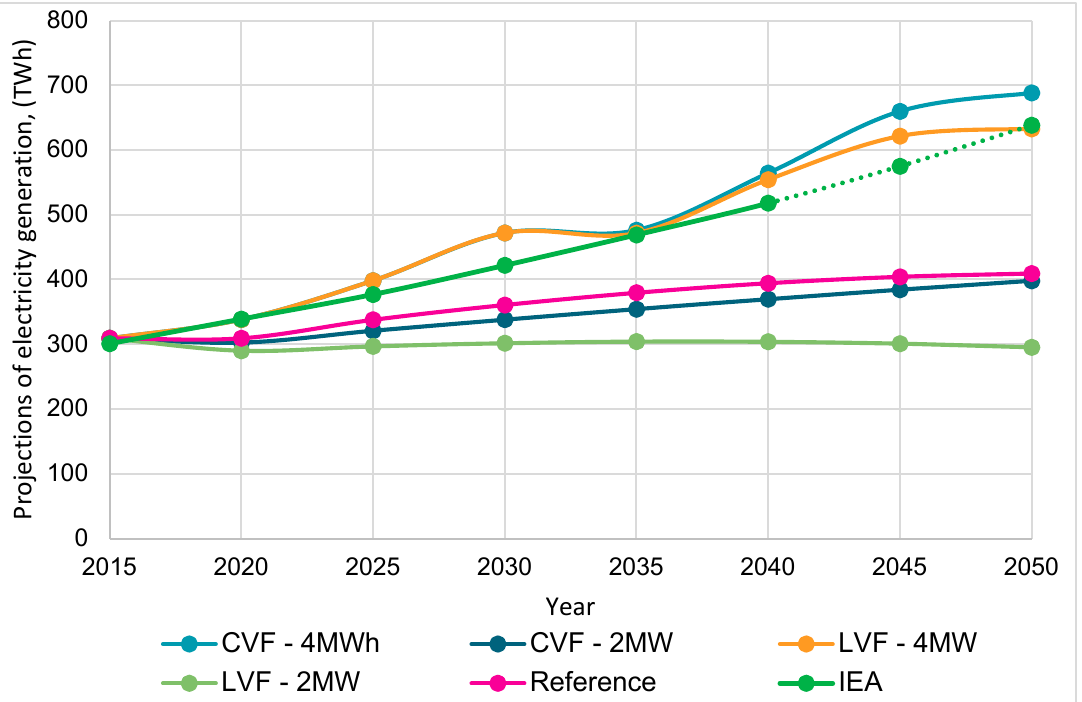
Figure 10. Projections of electricity generation to 2050. Source: Own elaboration with data from this work and previous publication [2,30].